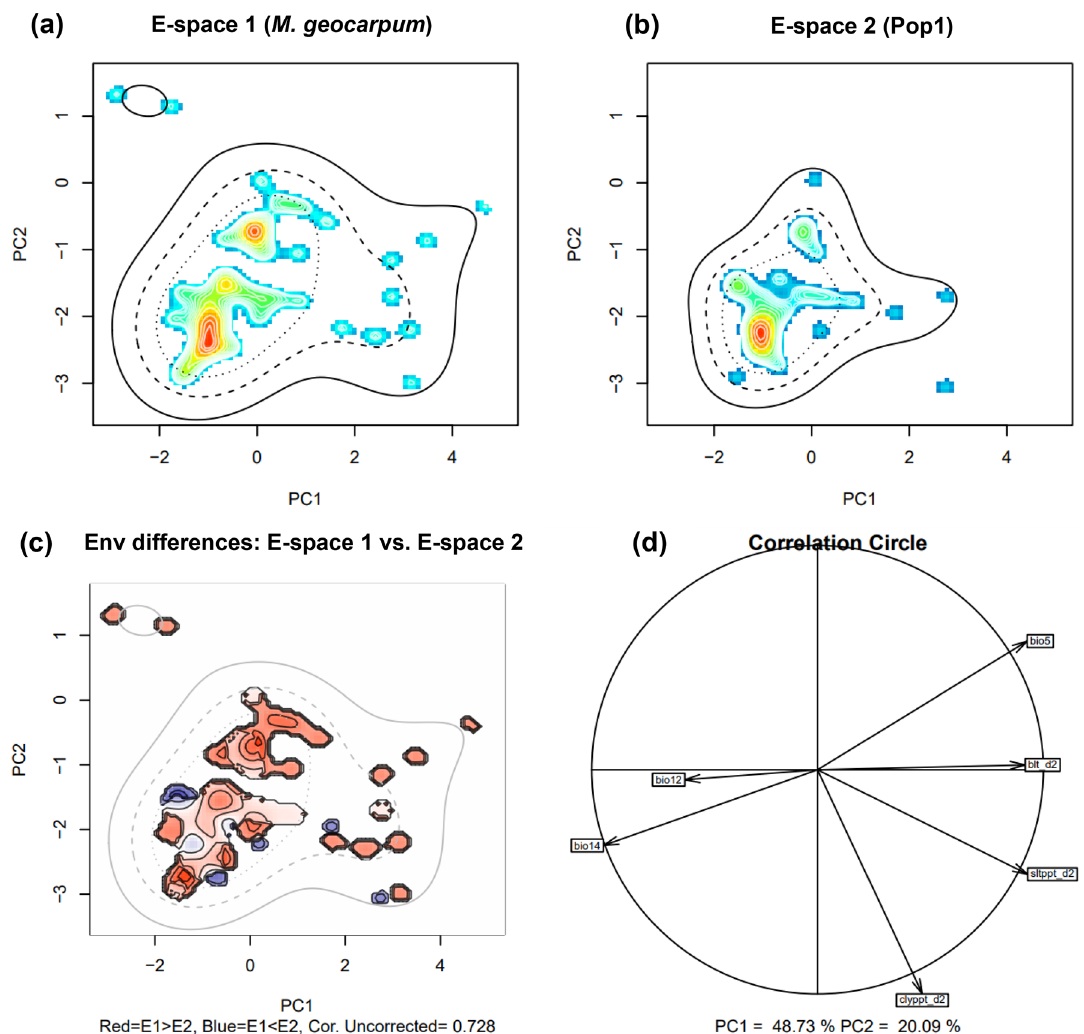
Figure 4. Niches of the two compared groups ( M. geocarpum and genetic Pop1) in two dimensional E-space. Graphs ( a ) and ( b ) represent the niches of the species and Pop1, respectively along the first two axes of the PCA. The occurrences are represented by kernel density isopleths, red colour indicates high density and blue colour indicates low density. Solid and dotted contour lines illustrate 100% and 50% of the available background (environmental space). ( c ) is the diference in the E-space of the two groups, and Niche E-space Correlation Index (NECI). NECI determines if one should correct the occurrence densities of each group by the prevalence of their environments in their range for equivalency and background tests. For high NECI (> 0.5) groups occupied niches are recommended to be corrected by the frequency of E-space in accessible environments to reduce the chances of committing type 1 errors, and ( d ) is the correlation circle based on the two principal components of the environmental input data. bio5 max temperature warmest month, bio12 mean annual rainfall, bio14 rainfall driest month, blt_d2 bulk density in kg/cubic-meter for 10 cm depth, clyppt_d2 soil texture fraction clay at 10 cm depth, Sltppt_d2 soil texture fraction silt in percent for 10 cm